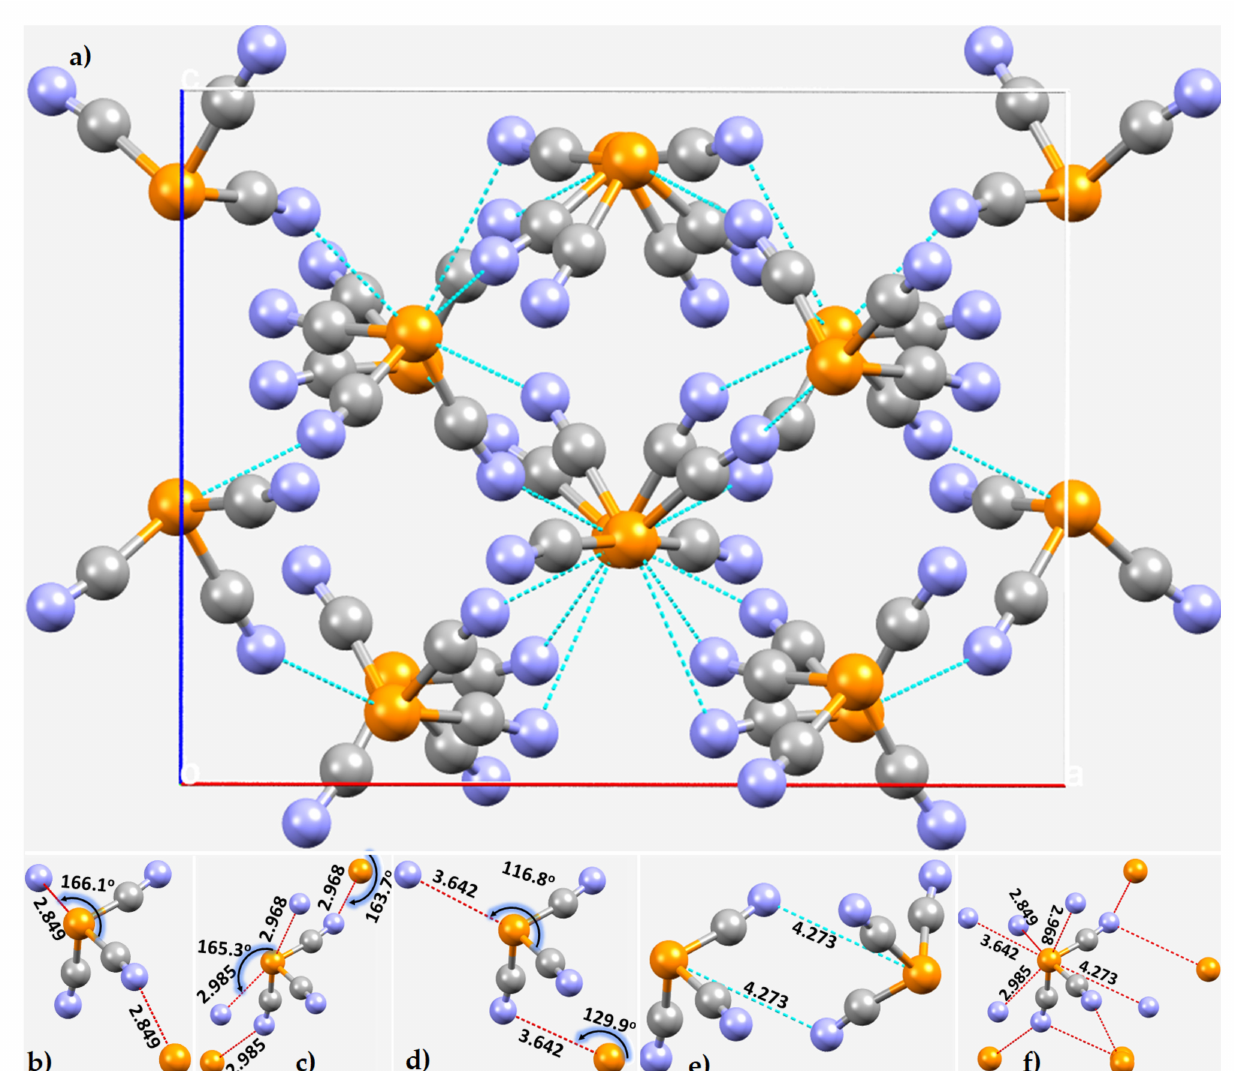
Figure 7. ( a ) The crystal structure of phosphorus tricyanide, P(CN) 3 , (ICSD ref. code 16587). ( b – f ) The nature of P ··· N intermolecular bonding modes between the P(CN) 3 units in the crystal. Selected bond lengths and angles in Å and degrees, respectively. Dotted lines in red/cyan between N and P atoms (balls colored blue and orange, respectively) represent pnictogen